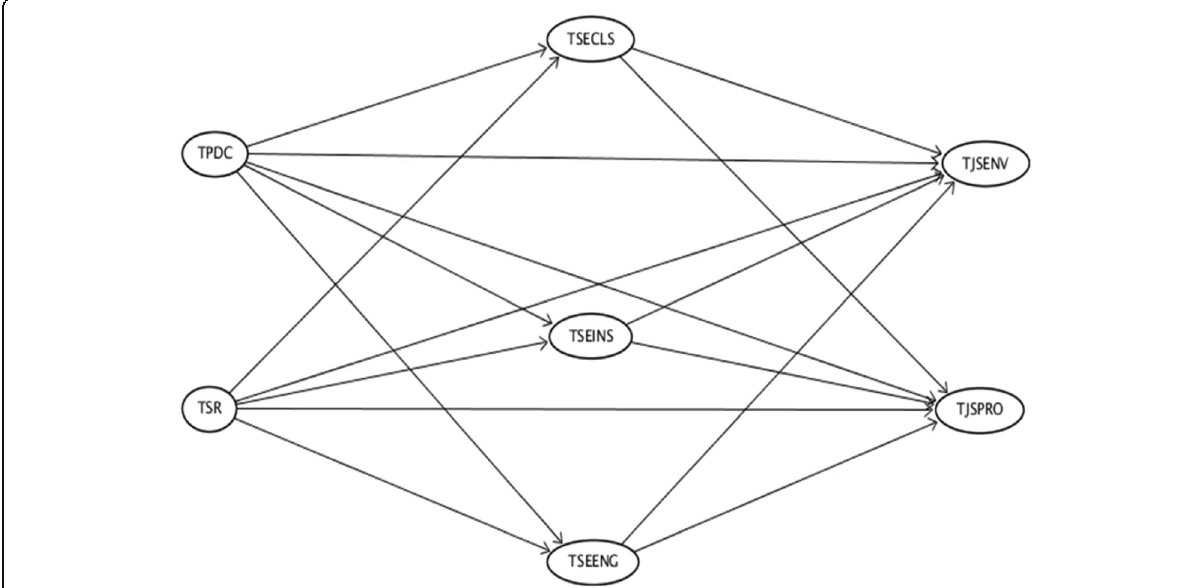
Fig. 1 A conceptual model of the relations between school climate (TPDC, teachers ’ perceived disciplinary climate and TSR, teacher-student relations ), job satisfaction (TJSENV, job satisfaction with work environment and TJSPRO, job satisfaction with profession), and teacher self-efficacy (TSECLS, self-efficacy in classroom management; TSEINS, self-efficacy in instruction; and TSEENG, self-efficacy in student